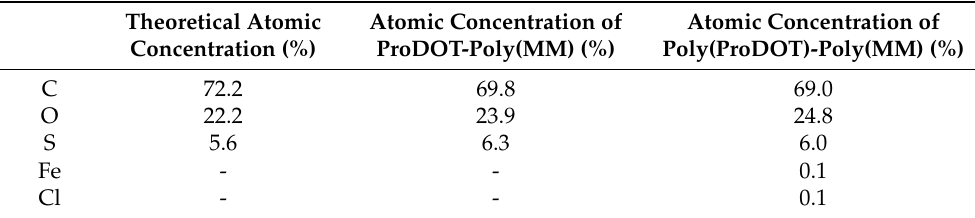
Table 2. Atomic concentration determined by XPS for ProDOT-Poly(MM) and Poly(ProDOT)- Poly(MM) brushes grafted from quartz.